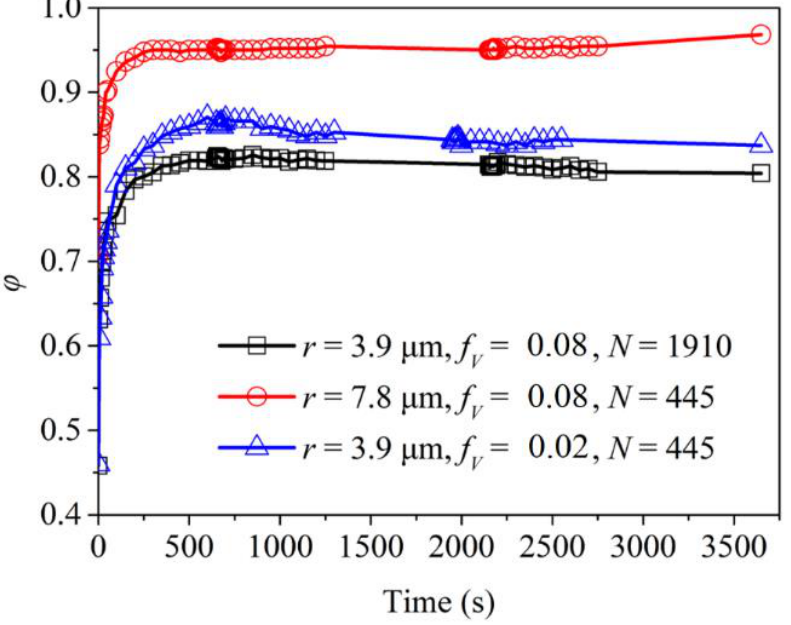
Figure 4. Evolutions of the number fractions of the particles contacting with grain boundary.